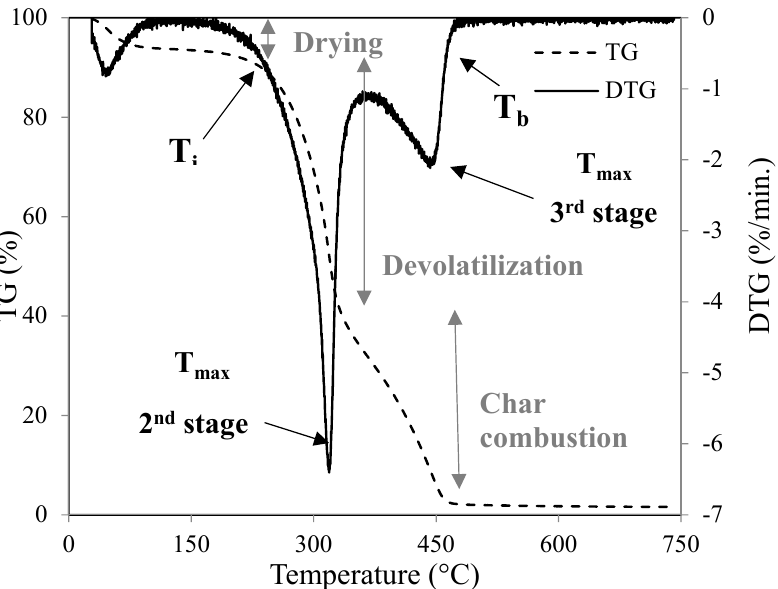
Figure 2. Interpretation of the thermogravimetric and calorimetric analysis (DSC-TGA) results. Mass loss as a function of temperature (dashed line) and derivative thermogravimetric curve (DTG) curve (continuous line) during the combustion of wood.